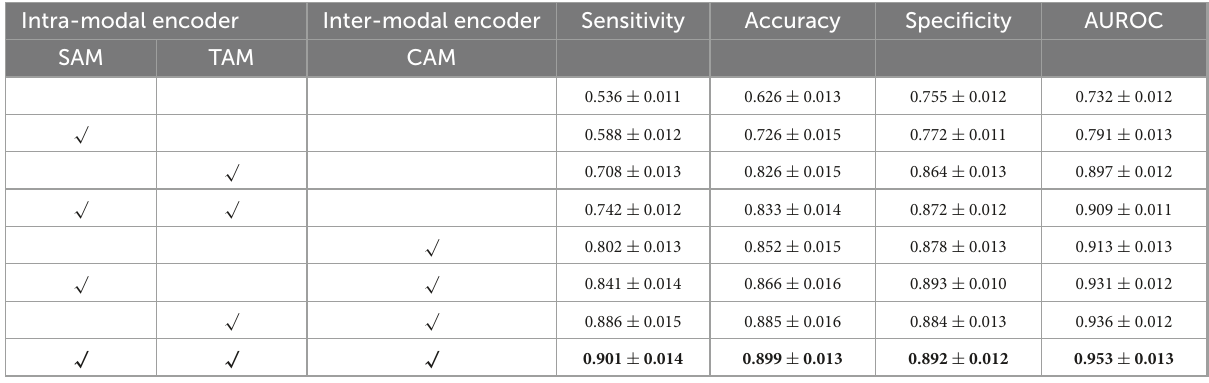
TABLE 2 Quantitative results on Alzheimer’s Disease Neuroimaging Initiative (ADNI) datasets for the proposed method with or without the specified components. Intra-modal